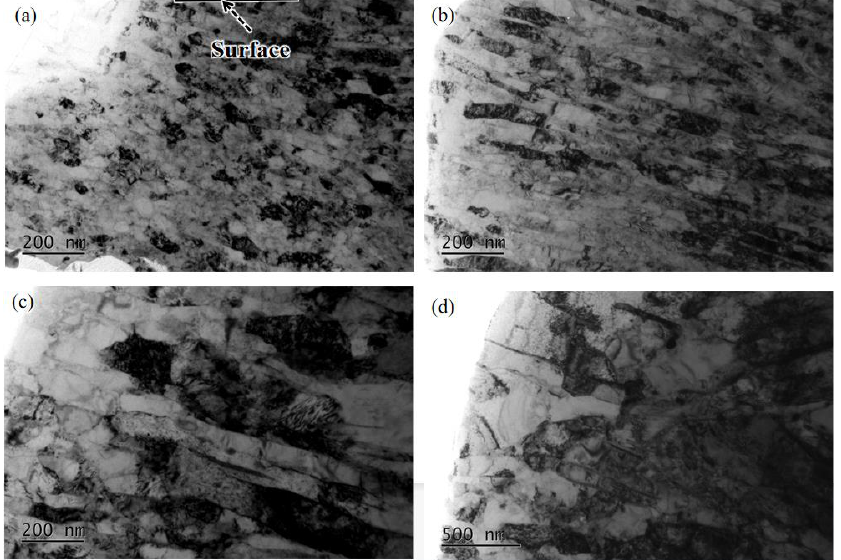
Figure 10. Bright field images of microstructural changes of SUR 2 samples at different distances. ( a ) 0 –1.5 μm, ( b ) 10 μm, ( c ) 15 μm, ( d ) 20 μm.